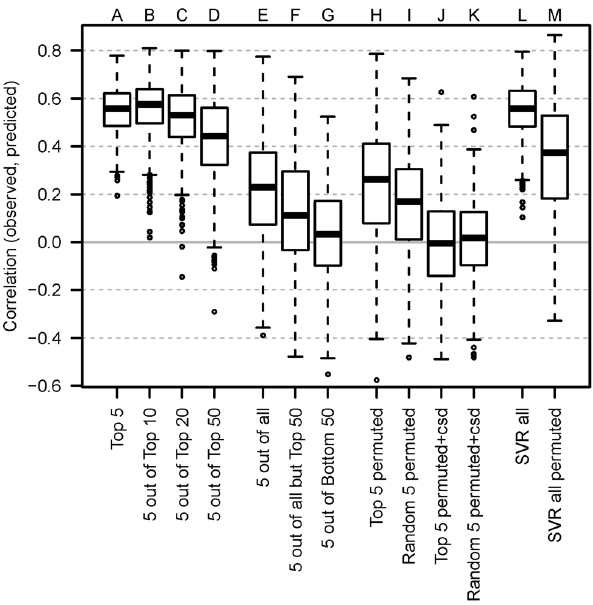
Figure 3. Prediction evaluation. The correlation between observed and predicted HP in models incorporating 5 metabolites. The metabolites have been selected based on a previous ranking (cf. Figure 2). It can be seen that good prediction accuracies are only obtained for high ranked metabolites and not for low ranked metabolites, which perform comparable to permuted data sets. Metabolite input matrices X pp were established as described in